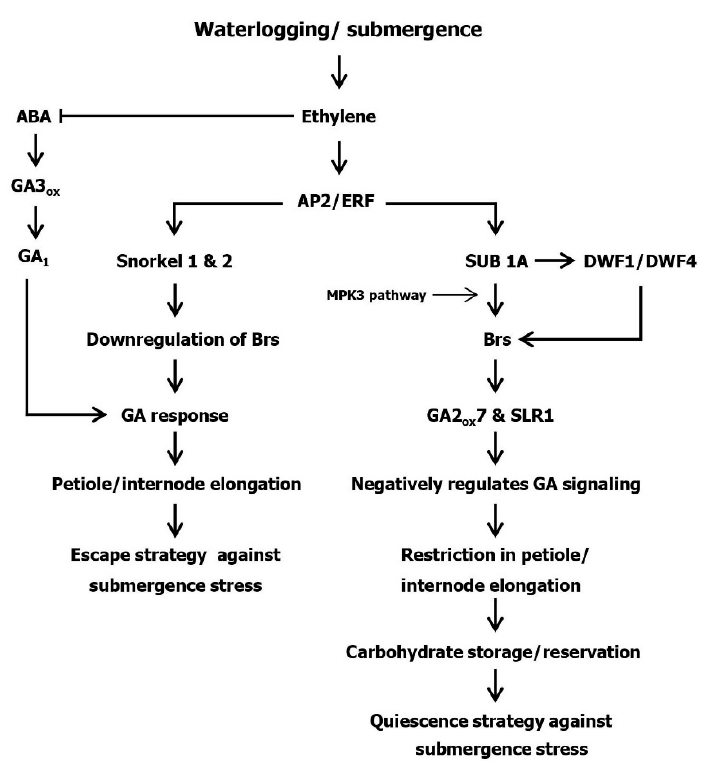
Figure 1. Ethylene-mediated escape and quiescence strategies in plants against submergence stress. Enhanced ethylene expression under submergence stress induces Snorkel and Sub1A genes for escape and quiescence strategies respectively. Ethylene suppresses ABA expression, which triggers GA 1 expression for escape strategy in plants. ABA: Abscisic acid; AP2/ERF: Apelata2/Ethylene response factor; Brs: Brassinosteroids; DWF1/4: Dwarf 1 / 4 ; GA 1 : Gibberellins 1; GA2ox7: GA 2 oxidase7; GA3ox: GA 3 oxidase; Sub1A: Submergence1A; SLRL1: SLR1 Like-1.